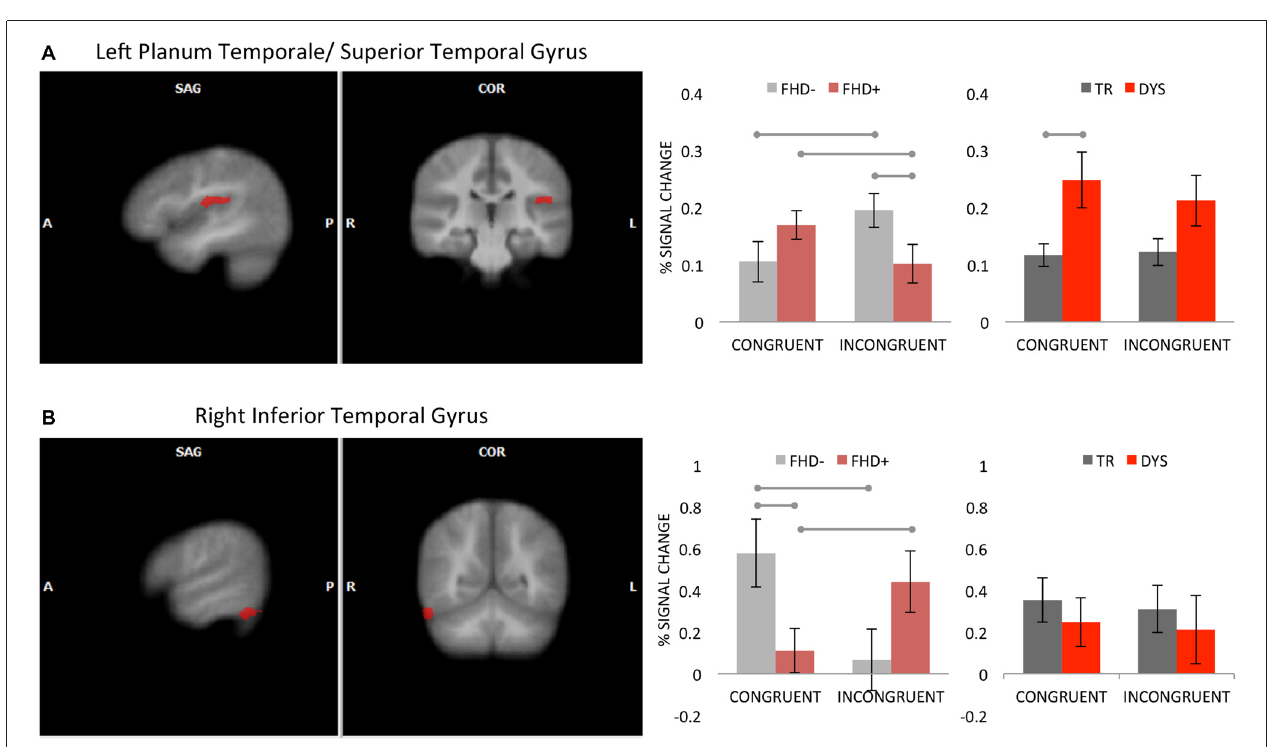
FIGURE 3 | Interaction effect between group and multisensory conditions (congruent, incongruent) in the left planum temporale/superior temporal gyrus (PT/STG) (A) and in the right inferior temporal gyrus (B) . The clusters are displayed on average brain from all participants at voxel-wise threshold of p < 0.01, corrected for multiple comparisons using cluster extent threshold of p < 0.05. Bar graphs illustrate the percent signal change with SEM for multisensory conditions in FHD − and FHD+ (horizontal lines illustrate significant post hoc tests) as well as in DYS and typical reading (TR) children (horizontal line illustrates significant bootstrap